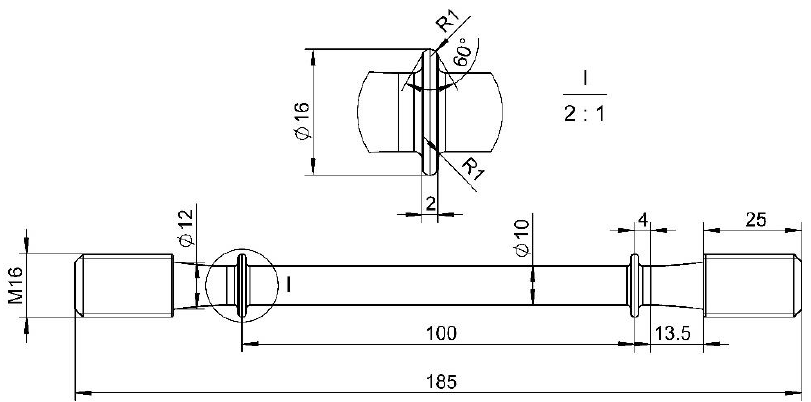
Figure 4. Dimension of stress relaxation specimen